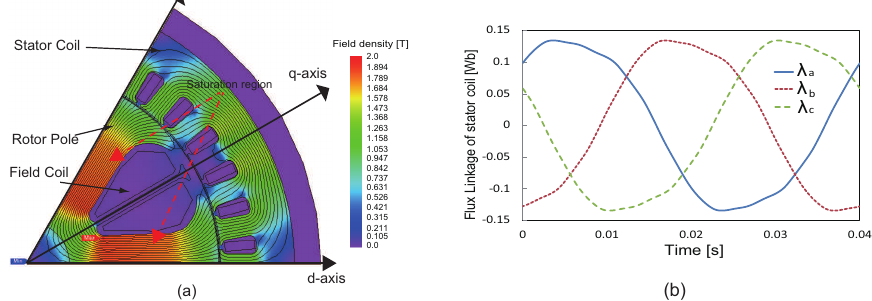
Figure 3. Flux linkage calculation when i f = 6 A: ( a ) Finite-element analysis model and ( b ) flux linkages of stator coils.